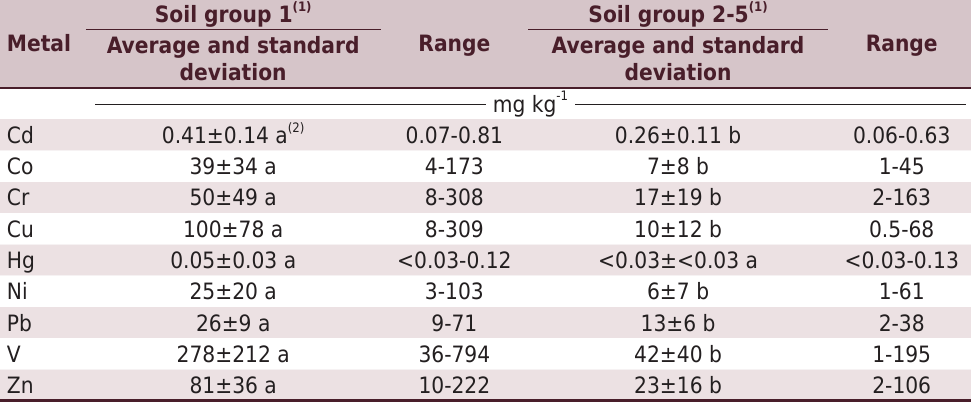
Table 5. Average contents, standard deviations, and ranges of semitotal Cd, Co, Cr, Cu, Hg, Ni, Pb, V, and Zn in soil group 1 and soil group